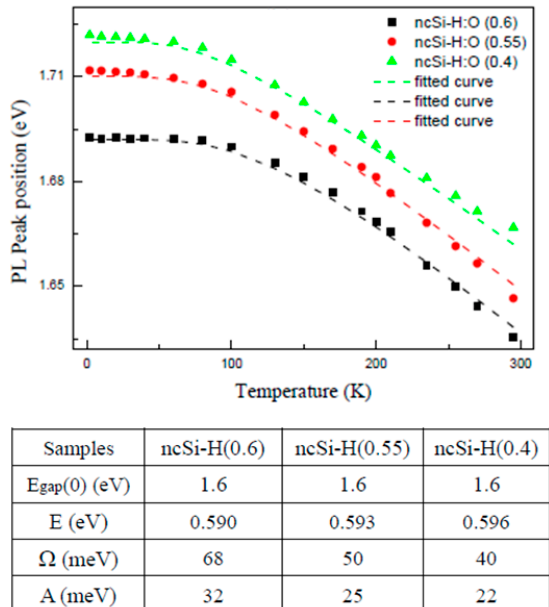
Figure 5. Plots of PL peak energy for ncSi-H:O (0.6), ncSi-H:O (0.55), and ncSi-H:O (0.4). Dotted lines are the fitting results according to Equation (2). Fitting parameters (E, Ω , and A) are tabulated.